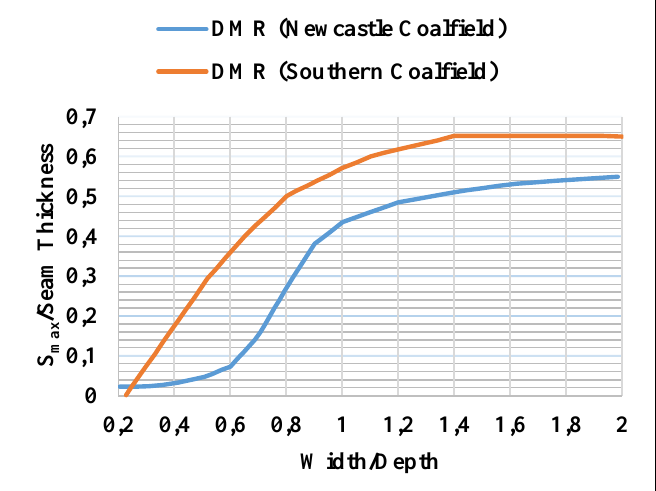
Figure 3: DMR subsidence prediction method.